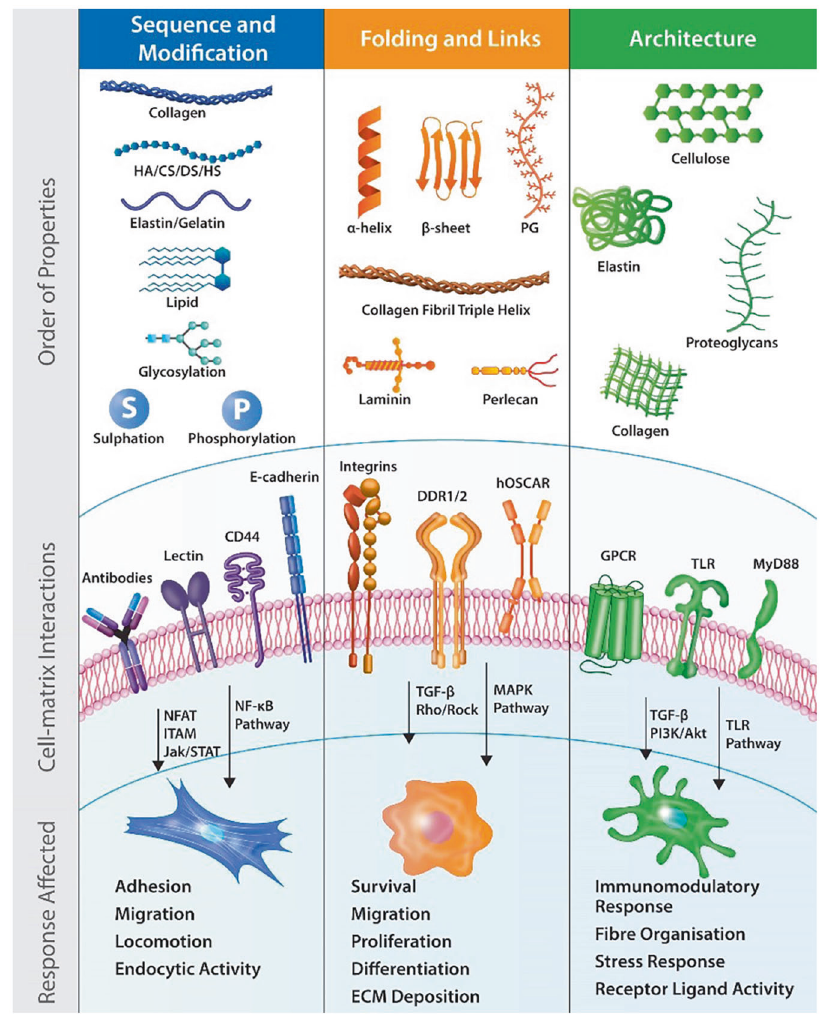
Fig. 1 Examination of functional sites on macromolecules from sequentially based cell recognition to tertiary, 3-dimensional architectures that in fl uence cell signalling. Cell surface receptors recognise material motifs and activate speci fi c signalling cascades in response. CD44 cluster of differentiation 44, CS chondroitin sulphate, DDR1/2 discoidin domain receptors 1/2, DS dermatan sulfate, GPCR G-protein coupled receptor, HA hyaluronic acid, hOSCAR human osteoclast associated receptor, HS heparan sulphate, ITAM immunoreceptor tyrosine based activation motif, Jak/STAT Janus kinase/signal transducer and activator of transcription, MAPK mitogen-activated protein kinase, MyD88 myeloid differentiation primary response 88, NFAT nuclear factor of activated T-cells, NF- κ B nuclear factor kappa-light-chain-enhancer of activated B cells, PI3K/Akt phosphatidylinositol 3-kinase/protein kinase B, PG proteoglycan, Rho/ROCK Rho/Rho-associated coiled-coil kinase, TGF- β transforming growth factor Beta, TLR toll-like